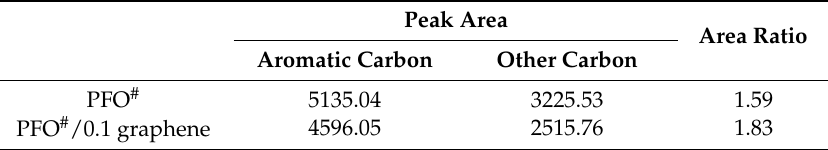
Table 5. Area Ratios of Chemical Bonding Peaks from C 1s XPS Spectra.